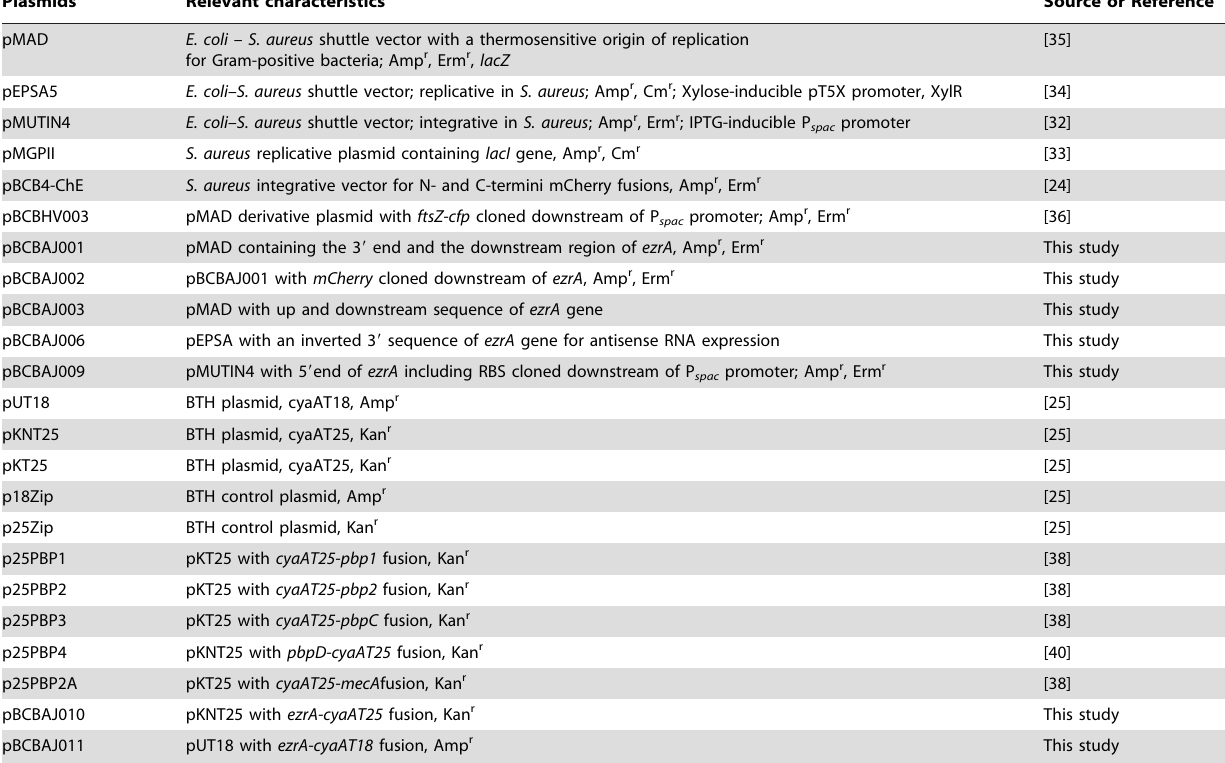
Table 1. Plasmids used in this study.